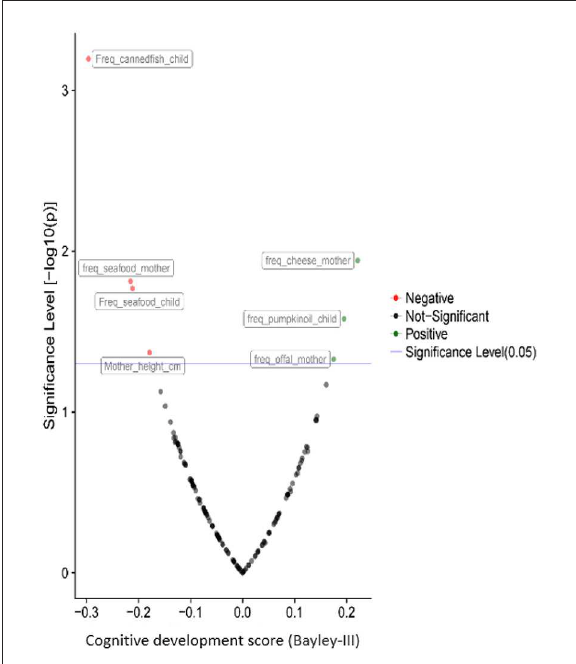
FIGURE7 Correlations of children’s cognitive development with prenatal and postnatal exposure factors during the second year of life based on the results from the PHIME cohort. The pathways resulted from the untargeted plasma metabolomics analysis. Besides the associations of psychomotor development of the child with the urea cycle and the amino acids metabolism, dietary and socioeconomic factors play a key role to child